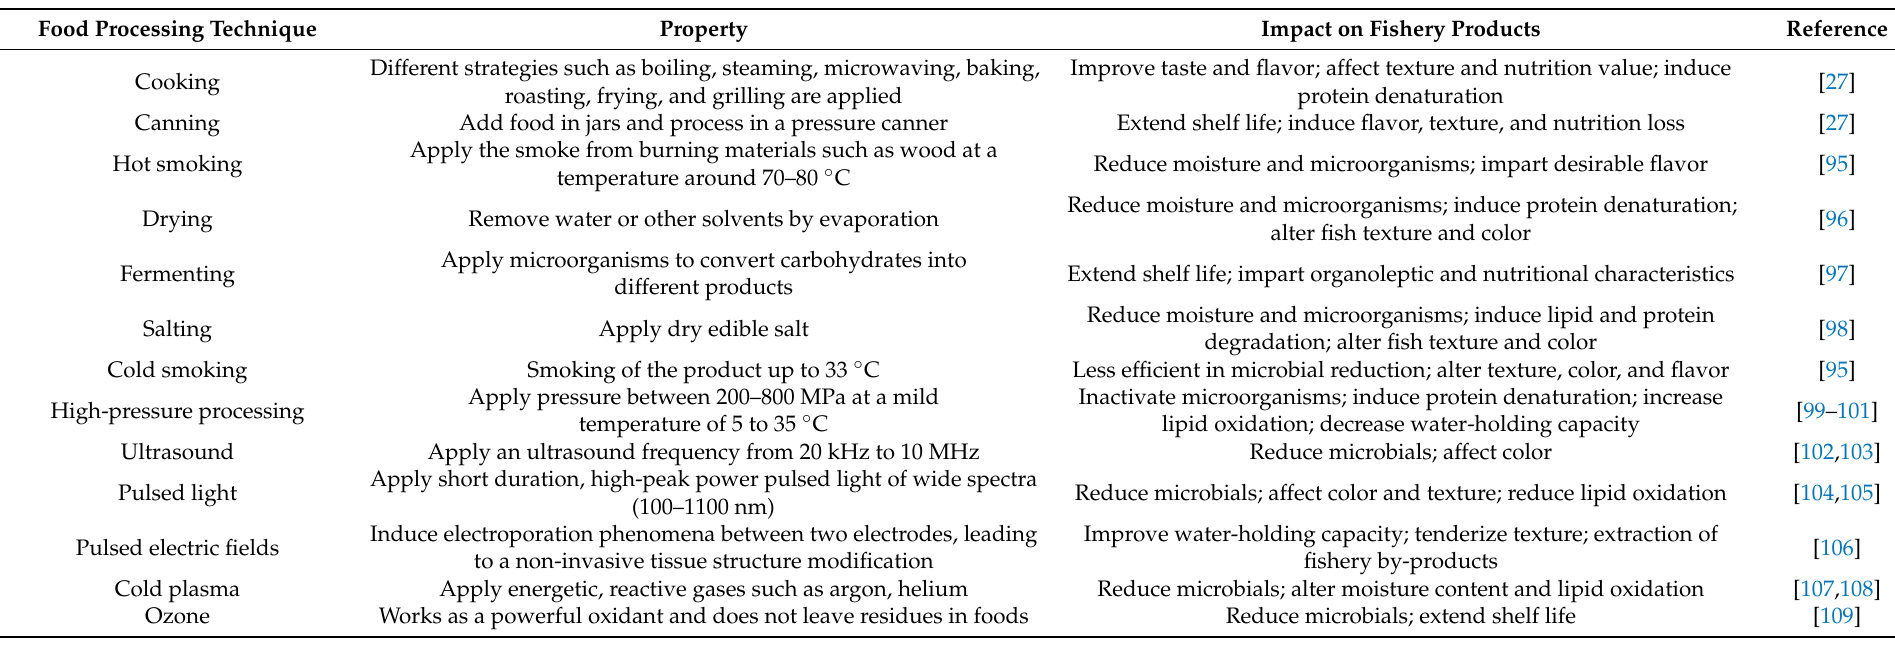
Table 4. Summary of food processing techniques on fish products from selected publications.